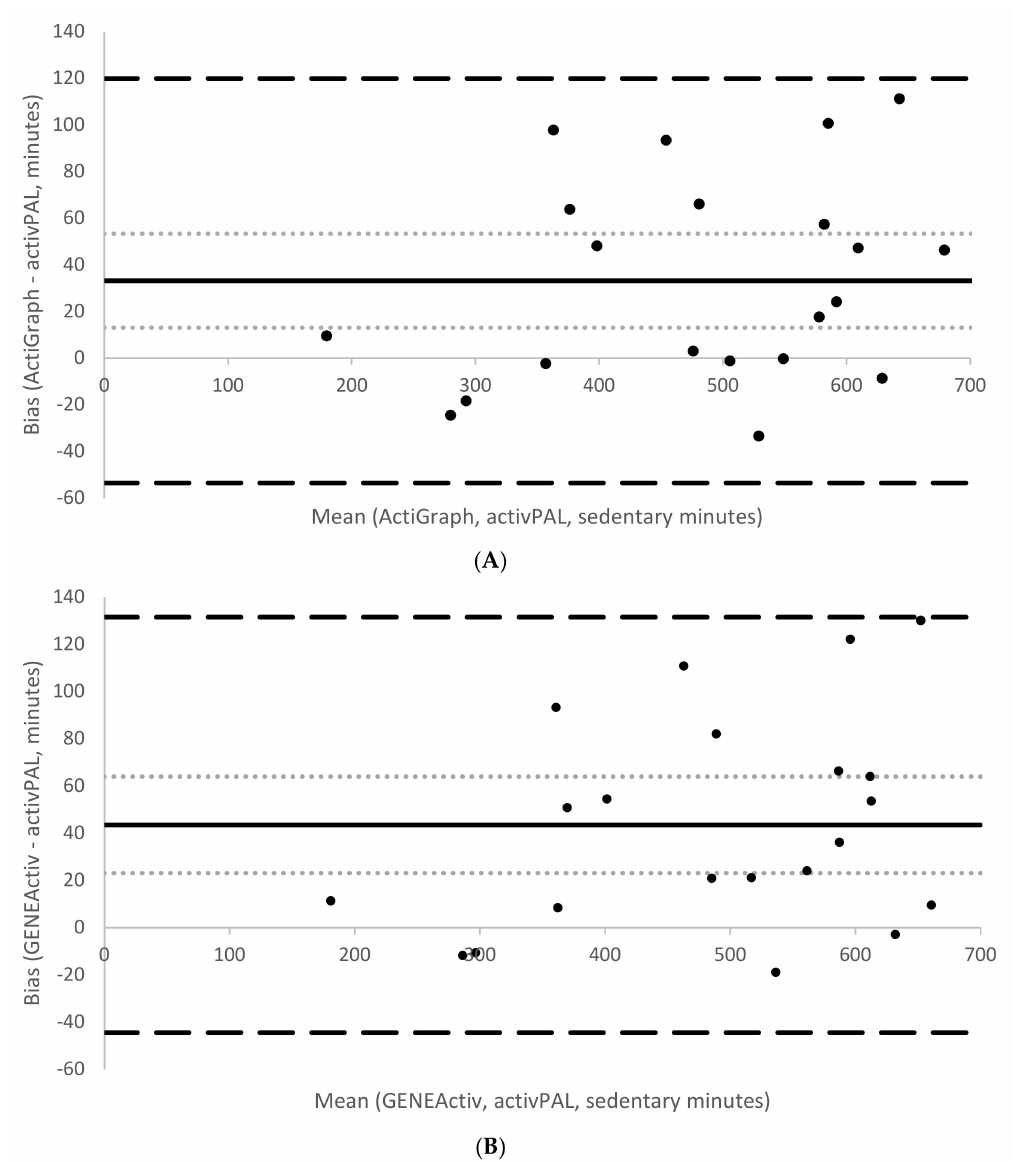
Figure 1. Mean bias (solid line), 95% CI of the mean bias (light dotted lines) and 95% limits of agreement (large dashed lines) for the sedentary free-living time estimated by the developed thresholds for Actigraph non-dominant wrist ( A ) and GENEActiv non-dominant wrist ( B ) relative to